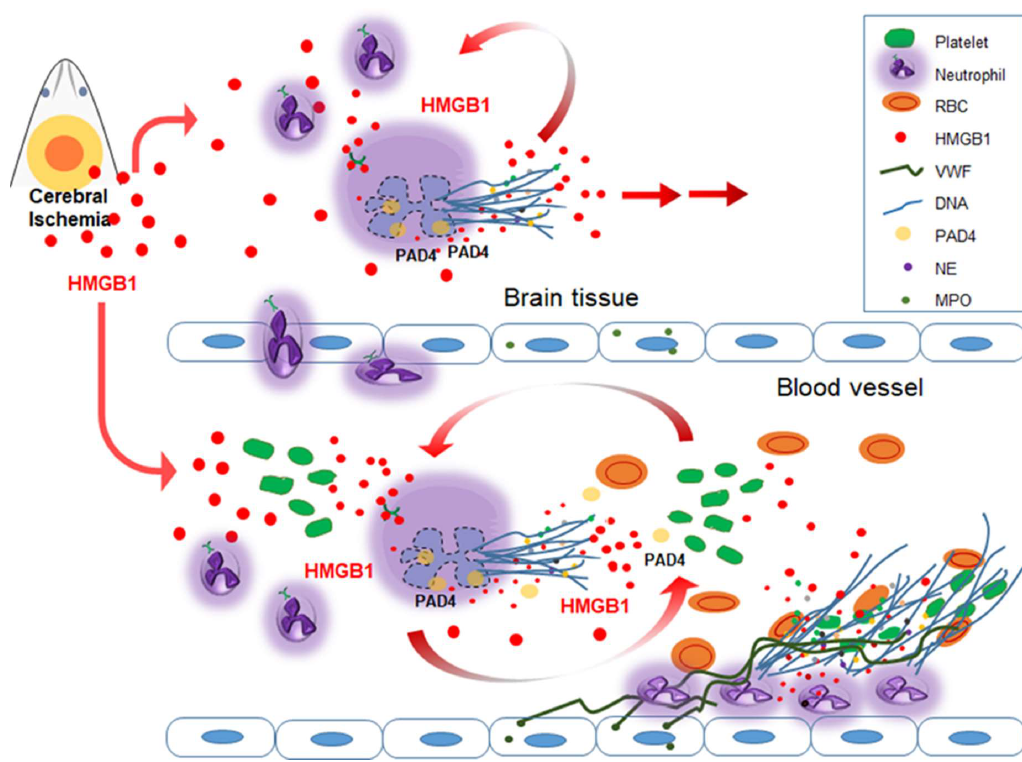
Figure 1. Diagram of the interplay between NETosis and thrombosis in cerebral ischemia and the function of HMGB1 in this process. HMGB1 is released from neurons and glia during the acute phase of cerebral ischemia. HMGB1 recruits neutrophils to the damaged brain region. NETosis occurs both in brain parenchyma and inside the blood vessel. In the brain parenchyma, extruded NET components induce brain damage and HMGB1 included in expelled neutrophil extracellular traps (NETs) accelerates this process. Inside the blood vessel, activated platelets release HMGB1, which in turn further induces NETosis and activates various procoagulant molecules. Platelets adhere to the endothelium by binding to von Willebrand factor (VWF) and interact with NETs that trap circulating procoagulant factors and red blood cell (RBC). HMGB1 derived from activated platelets and